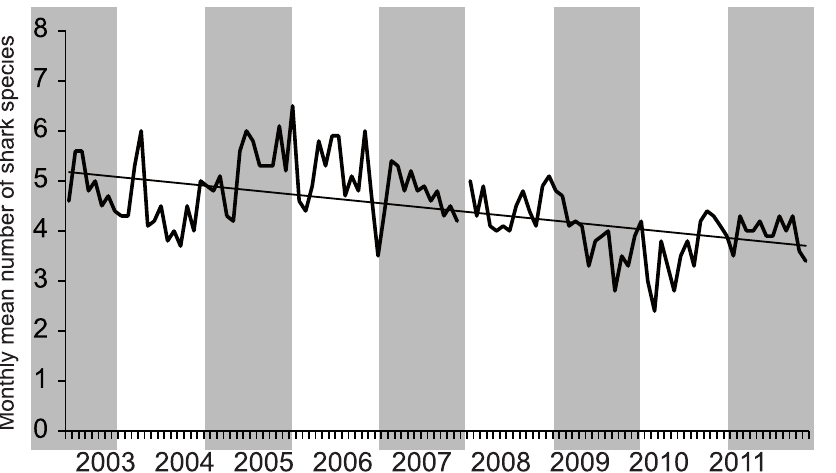
Figure 2. Monthly mean number of species encountered at the Shark Reef Marine Reserve per sampling day between January 2003 and June 2012. No data are available for January 2008. The mean number of species was calculated by dividing the number of species counted per day by the number of sampling days in the respective month.